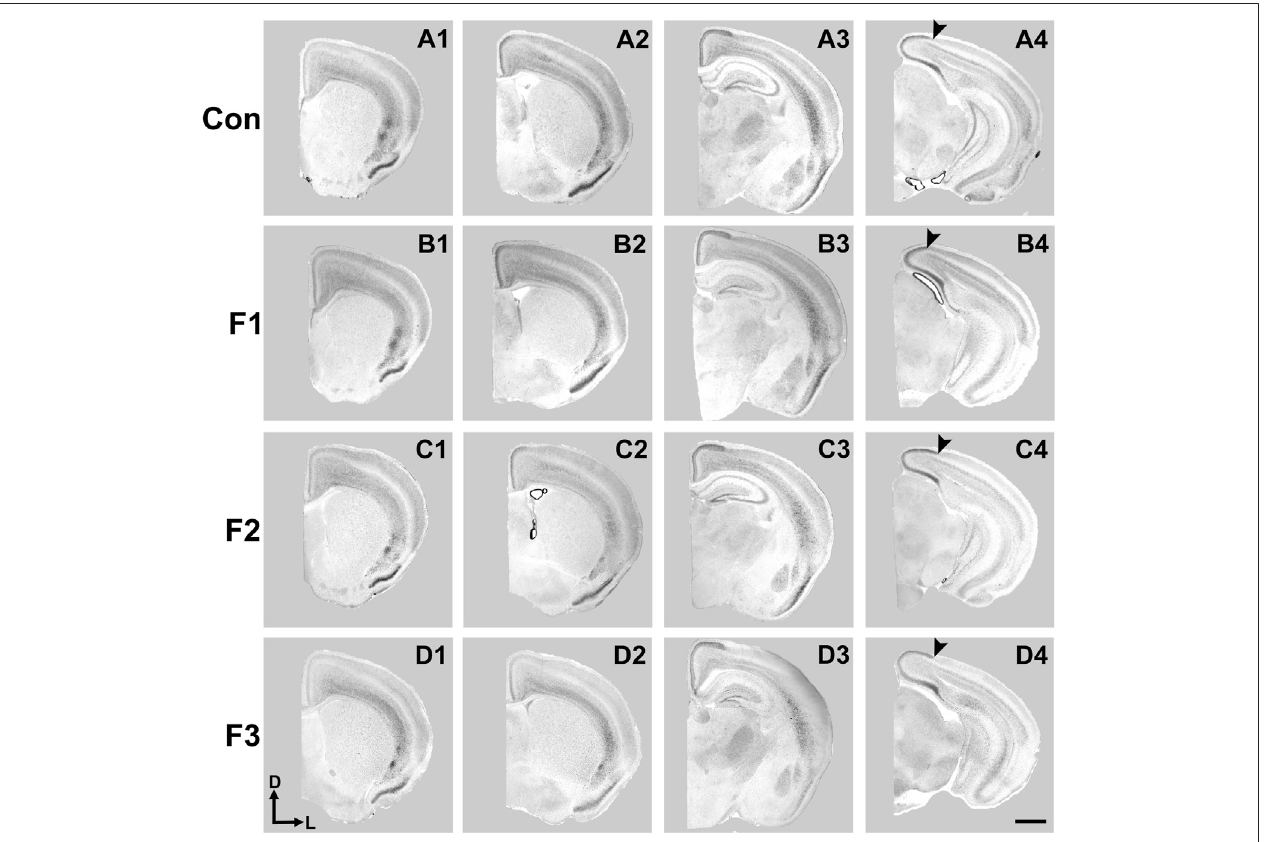
FIGURE 5 | Cortical Id2 expression at P20. Rostral-to-caudal series of coronal sections following in situ RNA hybridization with probes against Id2 in individual representative control (female, A1-4 ), F1 (female, B1-4 ), F2 (female, C1-4 ), and F3 (female, D1-4 ) mice. F1 mice display a pronounced shift in the lateral limit of the super fi cial Id2 band compared to controls ( A4 vs. B4 , arrows). Images oriented dorsal (D) up, lateral (L) right. Scale bar, 1 mm.